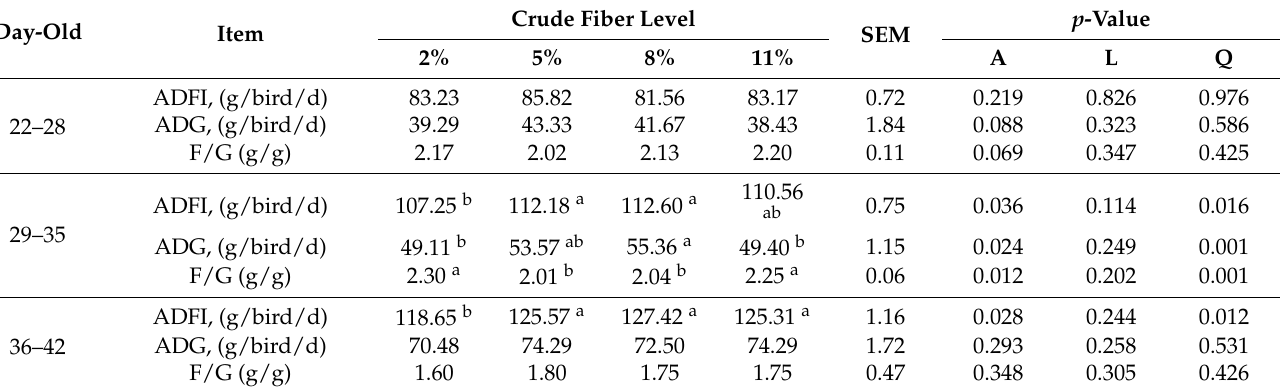
Table 2. Effects of dietary CF level on growth performance of broilers from day 22 to